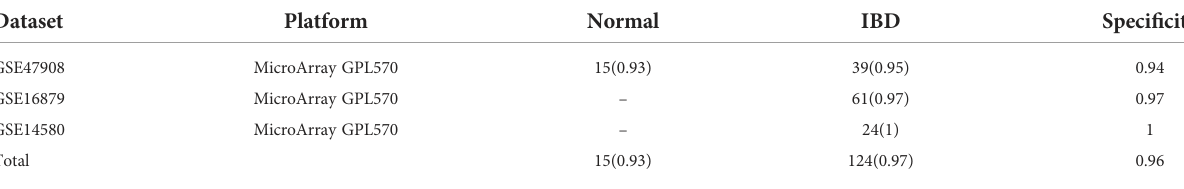
TABLE 4 The performance of the lncRNA pair biomarkers in independent in fl ammatory bowel disease and normal validation datasets. Accuracy is marked in parentheses.